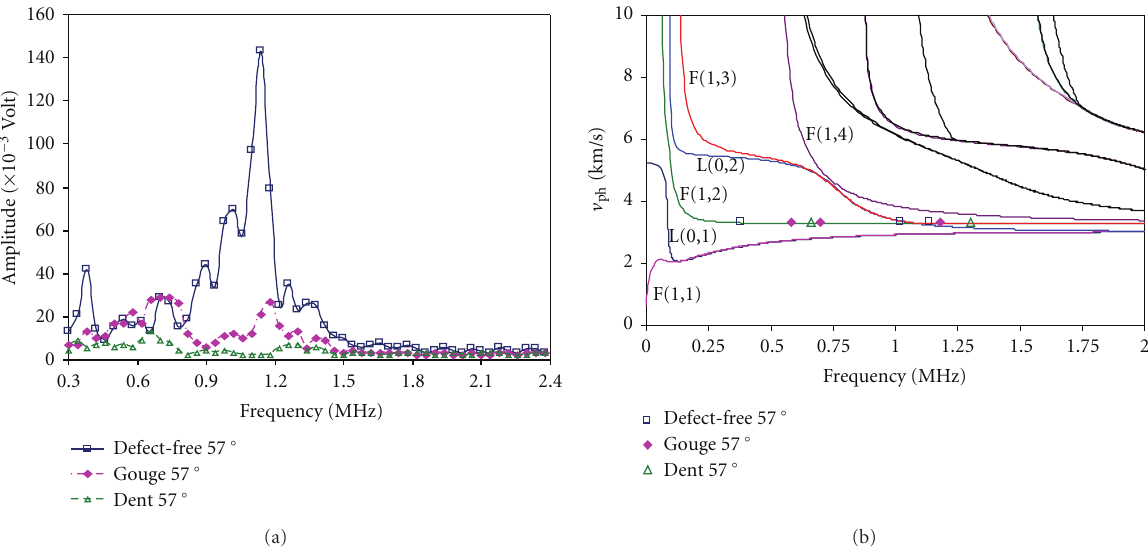
Figure 2: (a) experimental V ( f ) curves for defect-free and defective pipes for traction-free boundary condition for 57 ◦ incident angle for defective and defect free pipes (b) theoretical phase velocity dispersion curves obtained for a steel pipe with experimentally obtained phase velocities for modes generating at 57 ◦ incident